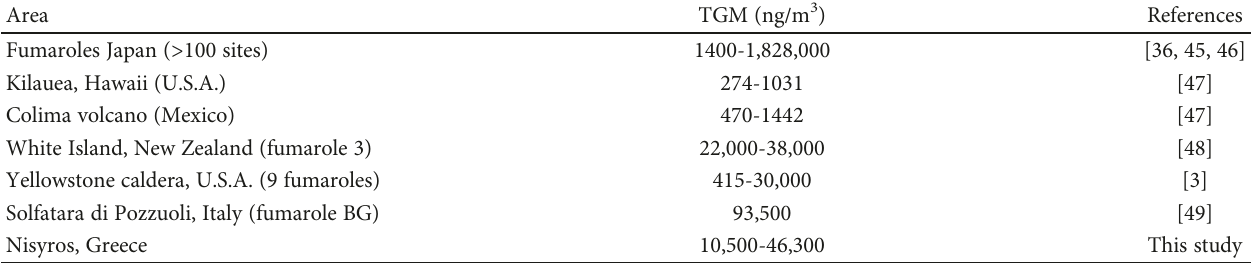
Table 4: Total gaseous mercury (TGM) concentrations in fumarolic gases.